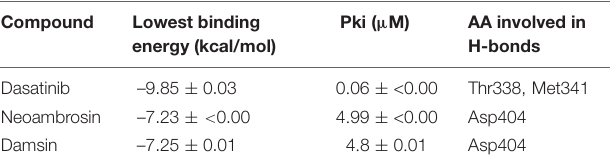
TABLE 2 | Molecular docking of dasatinib (3), neoambrosin (1), and damsin (2) to the c-Src kinase domain.